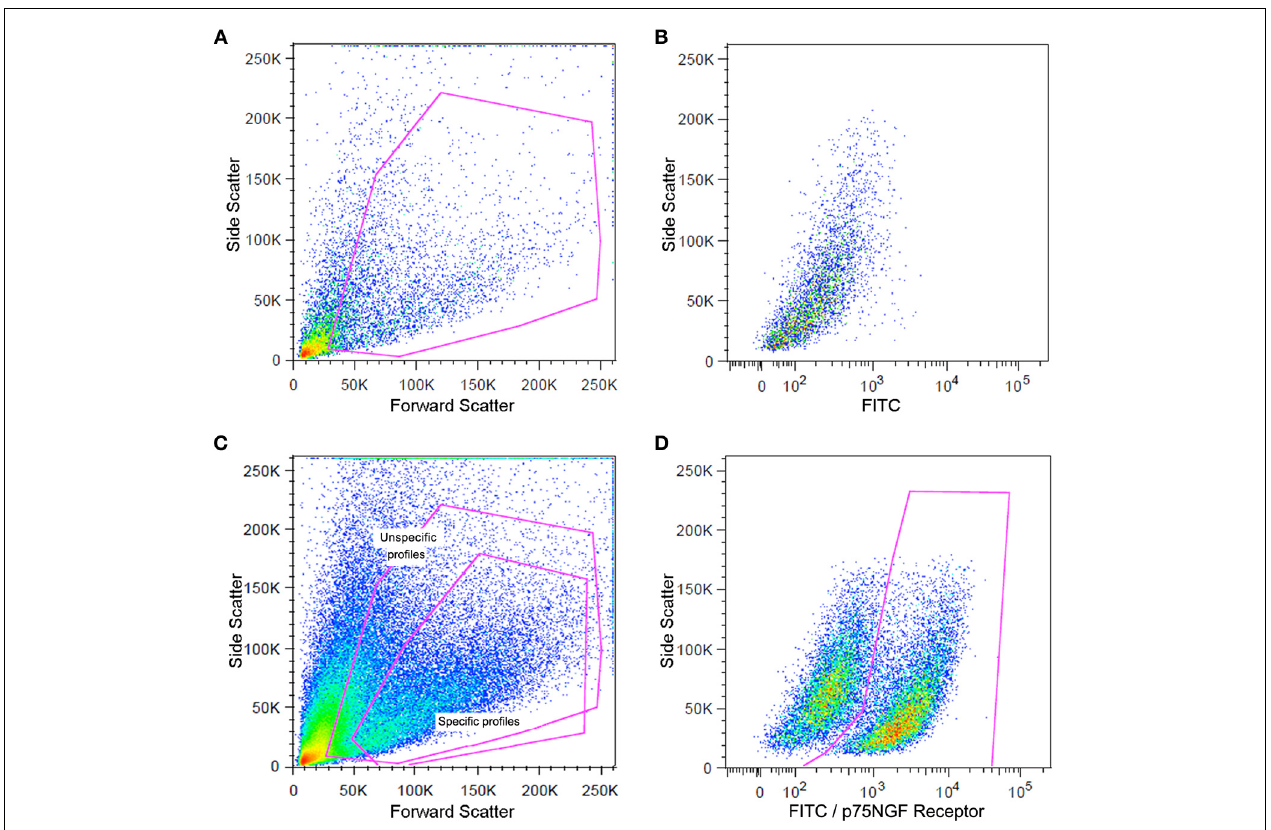
FIGURE 2 | Flow cytometry analysis of Schwann cells from a mouse sciatic nerve employed in the experiments. Dot plots indicate the total number of events in the sciatic nerve cell suspension and the dots inside the red box represent the excluded doublet and dead profiles, which have been eliminated by morphological criteria according to previous descriptions (Shapiro, 2005; Herzenberg et al., 2006) (A) . Dot plots of unspecific